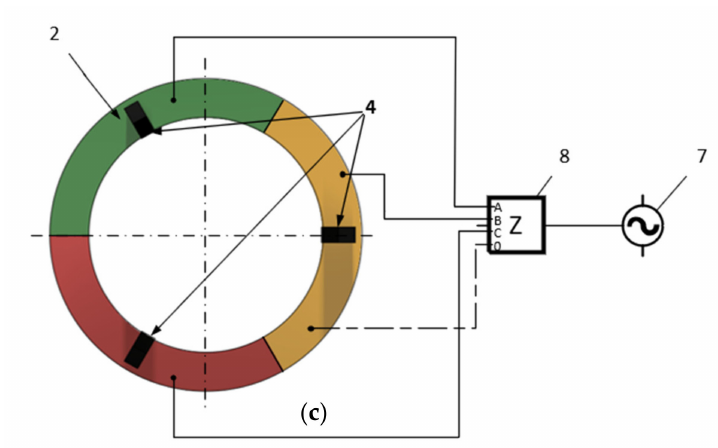
Figure 1. Structure of the piezoelectric 3 degrees of freedom (DOF) rotary ultrasonic motor (USM) with a spherical rotor ( a ); view of the piezoelectric unimorph actuator ( b ) and schematic representation of the USM drive and layout of segmented electrodes of the piezoelectric transducer ( c ): 1-spherical rotor; 2-piezoelectric transducer; 3-flange; 4-contact element; 5-nut; 6-bolt; 7-signal generator;